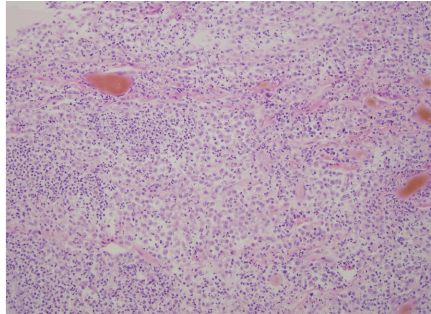
Figure 6: The inflammatory infiltrate is distinctive in that it is composed of recurring clusters of neutrophils surrounded by reactive foamy macrophages (pyogranulomas) which coalesce to create the limboscleral